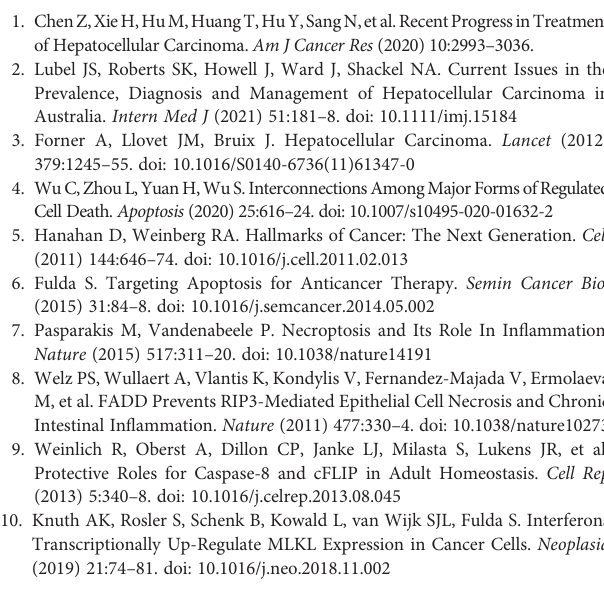
Supplementary Figure 1 | The fl owchart of the study procedures. Supplementary Figure 2 | Expression changes of 7 genes after gemcitabine treatment. Supplementary Table 1 | Summarizes of clinical